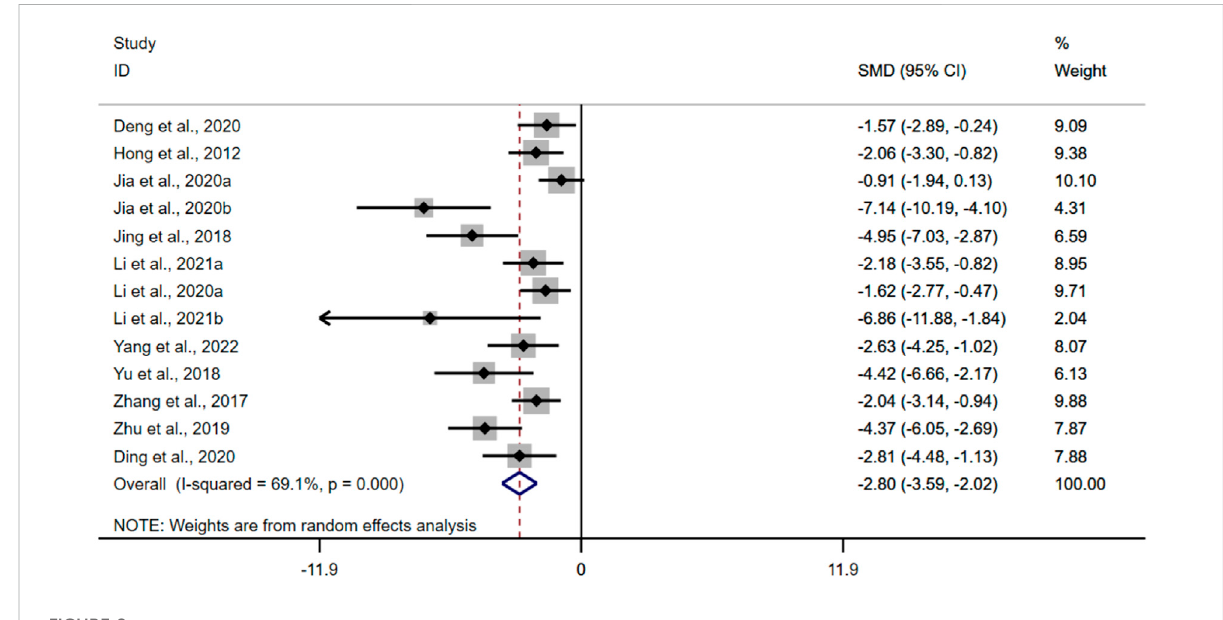
FIGURE 8 Forest plot: effect of berberine on MPO.